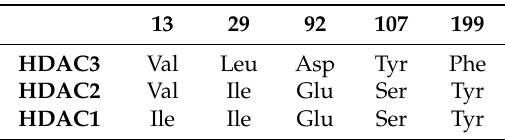
Table 1. Excerpt of a structural alignment of HDAC3 with HDAC 1 and 2 reveals five differences between HDAC3, and HDAC1 and 2. The amino acids are numbered according to the sequence of